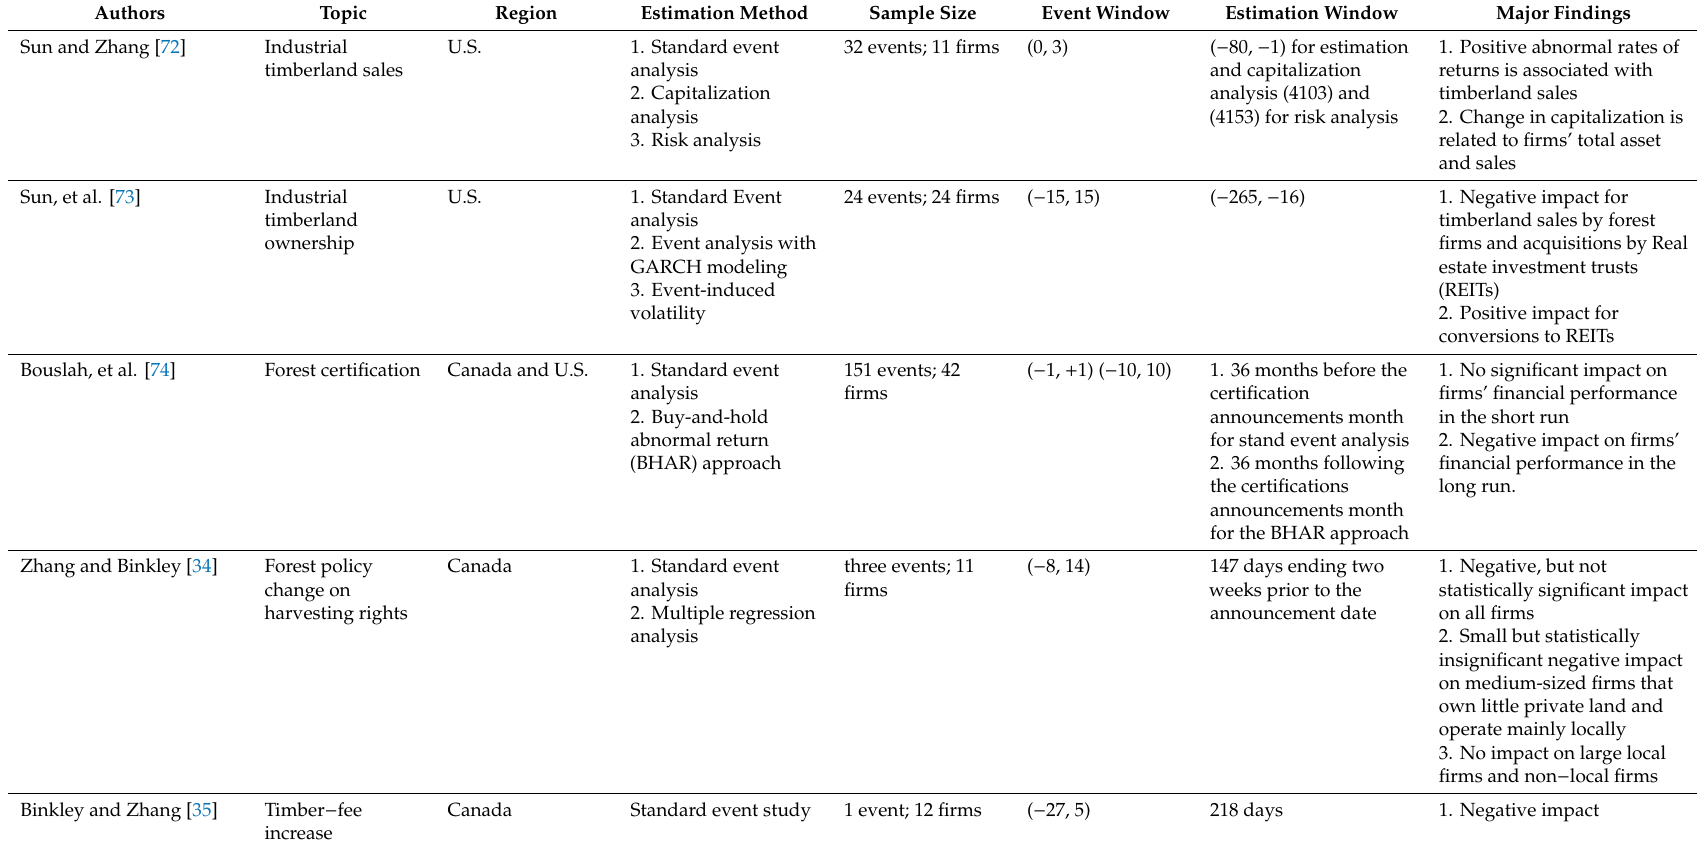
Table A1. Summary of event studies in forest economics and related